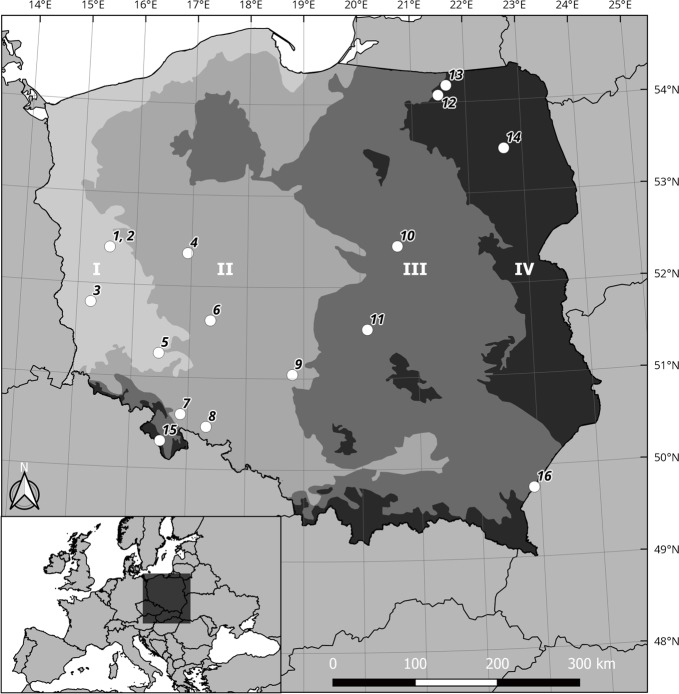
Distribution of the hibernation sites of Barbastella
barbastellus under study in four thermal regions.The map of thermal regions was created on the basis of the map of mean winter
temperatures by the Institute of Meteorology and Water Management IMGW for
years 1971–2000, available at http://klimat.pogodynka.pl/pl/climate-maps/?. Thermal
Regions: I (> 0°C), II (0°C to -1°C), III (-1°C to -2°C), IV (< -2°C).
The numbering of the hibernation sites (1–16) corresponds to that in Table 2.